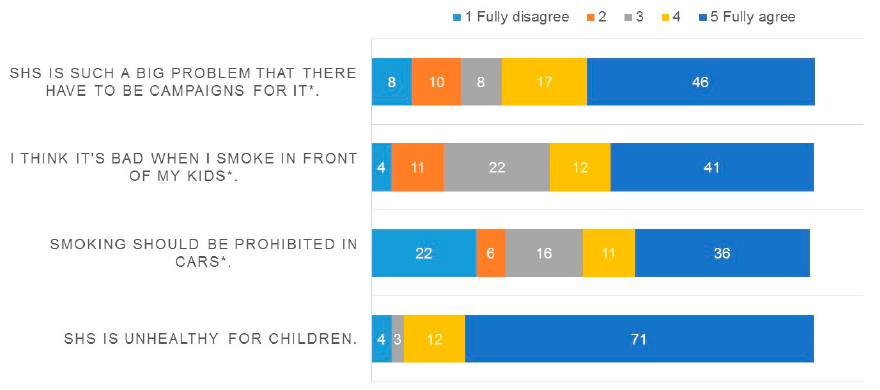
Figure 2. Attitude towards second hand smoke of the 121 participants in the quantitative evaluation of the campaign (* Original item formulated negatively; SHS = Second Hand Smoke).